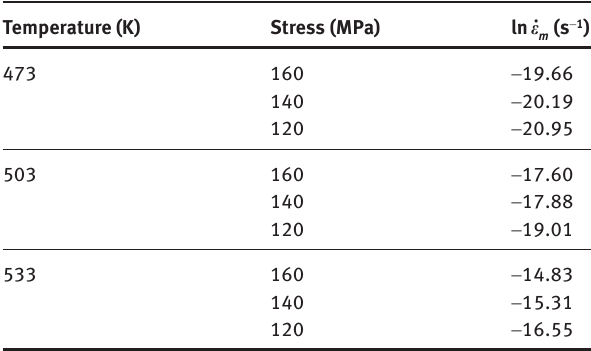
Table 1: Minimum creep rates of 2124-T851 aluminum alloy. Temperature